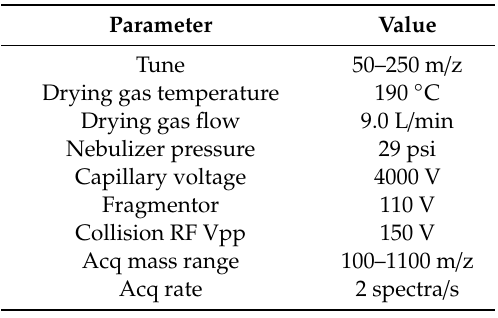
Table 2. Summary of source parameters for negative ion mode method.